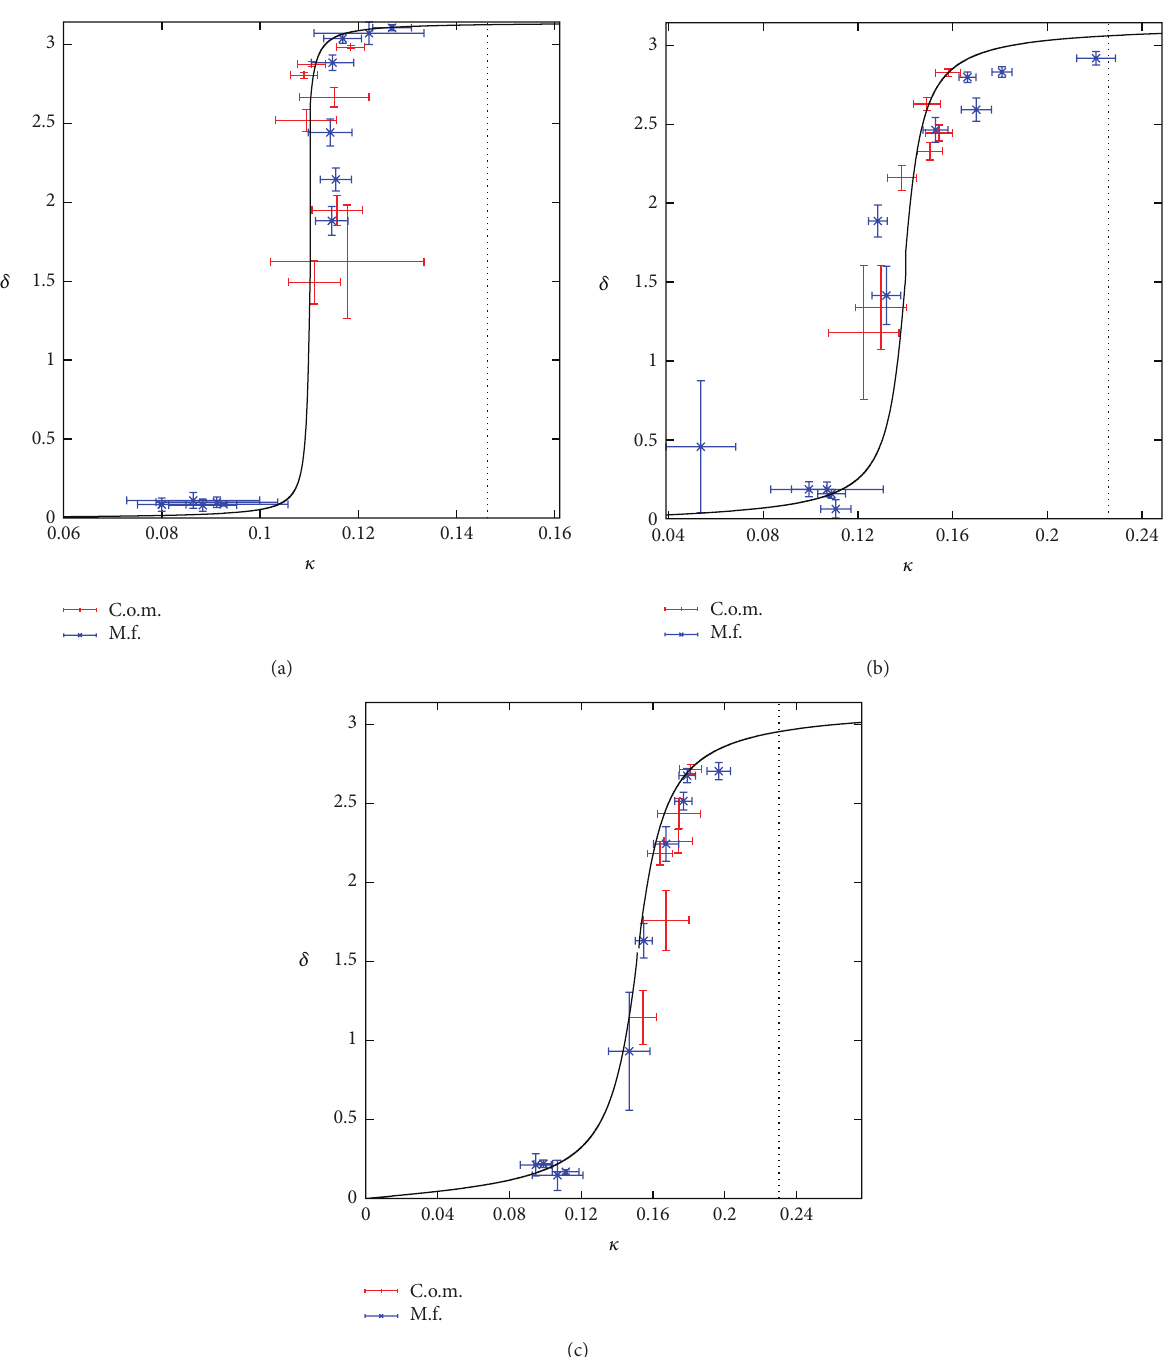
̂𝜆 ̂𝜆 = 0.001, 10, ∞ . From (a) to (c), the plots correspond to , respectively.